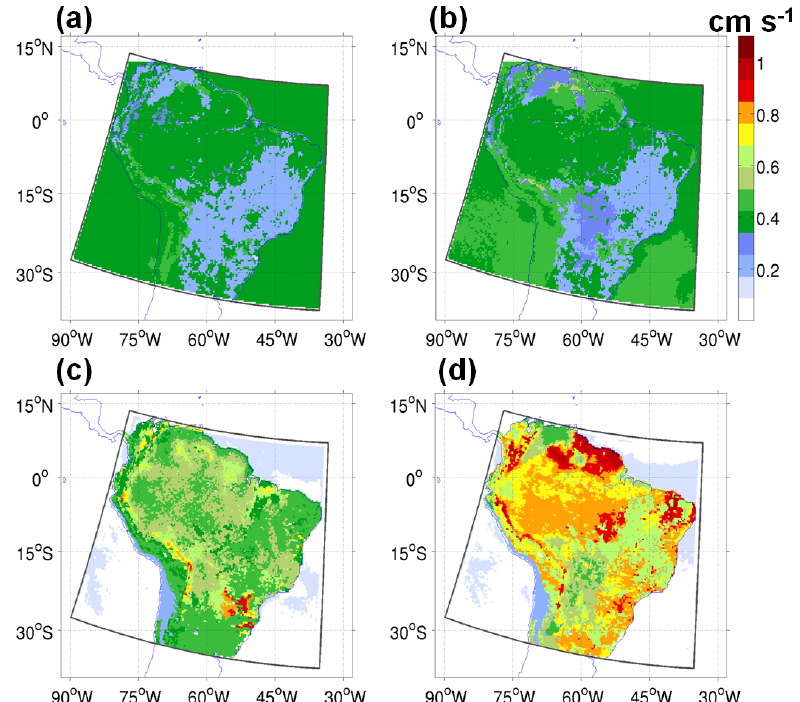
Figure 19. Same as Fig. 12, but daytime (11:00–21:00UTC) median deposition velocity (cms − 1 ) .